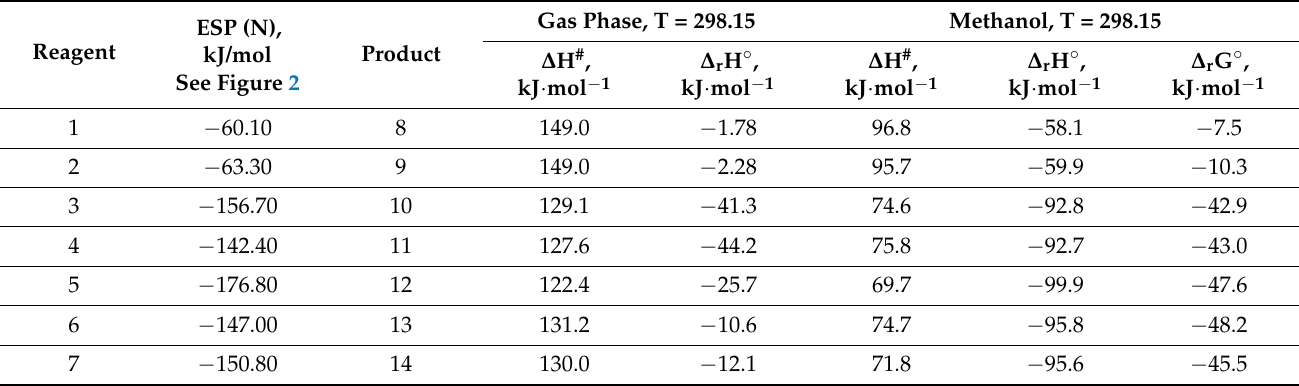
Table 2. Thermodynamic and activation parameters of 1,3-propanesulton cycle opening reactions by amides.